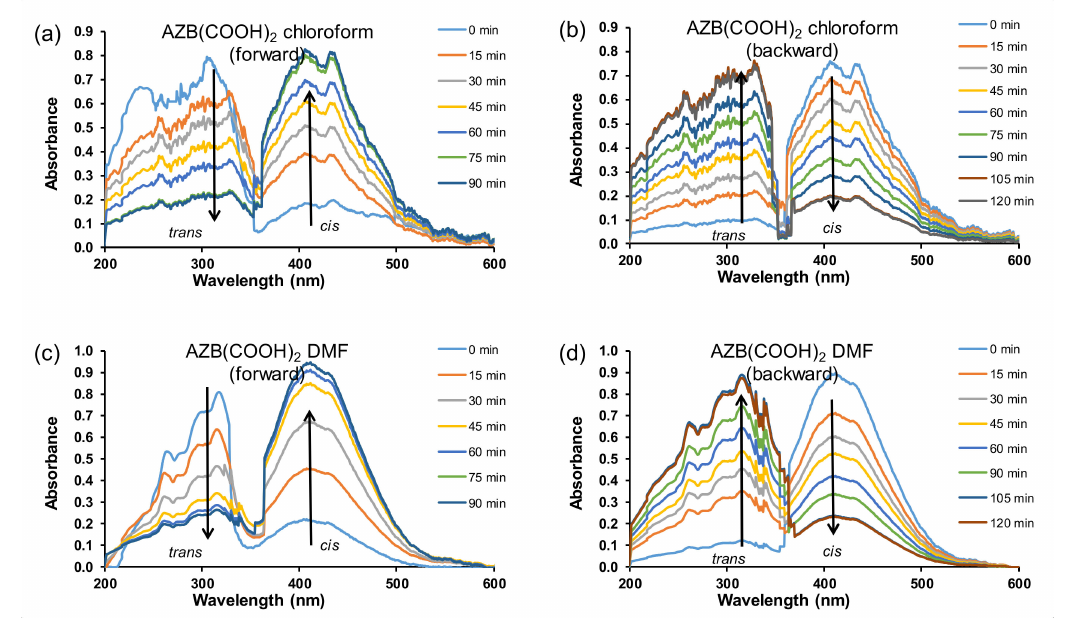
Figure 2. UV–Vis absorbance vs. wavelength AZB(COOH) 2 plots of trans – cis (forward) isomerisation ( a , c ) and cis–trans (backward) isomerisation ( b , d ) in the indicated solvents with concentrations of 15 ppm in chloroform and 20 ppm in